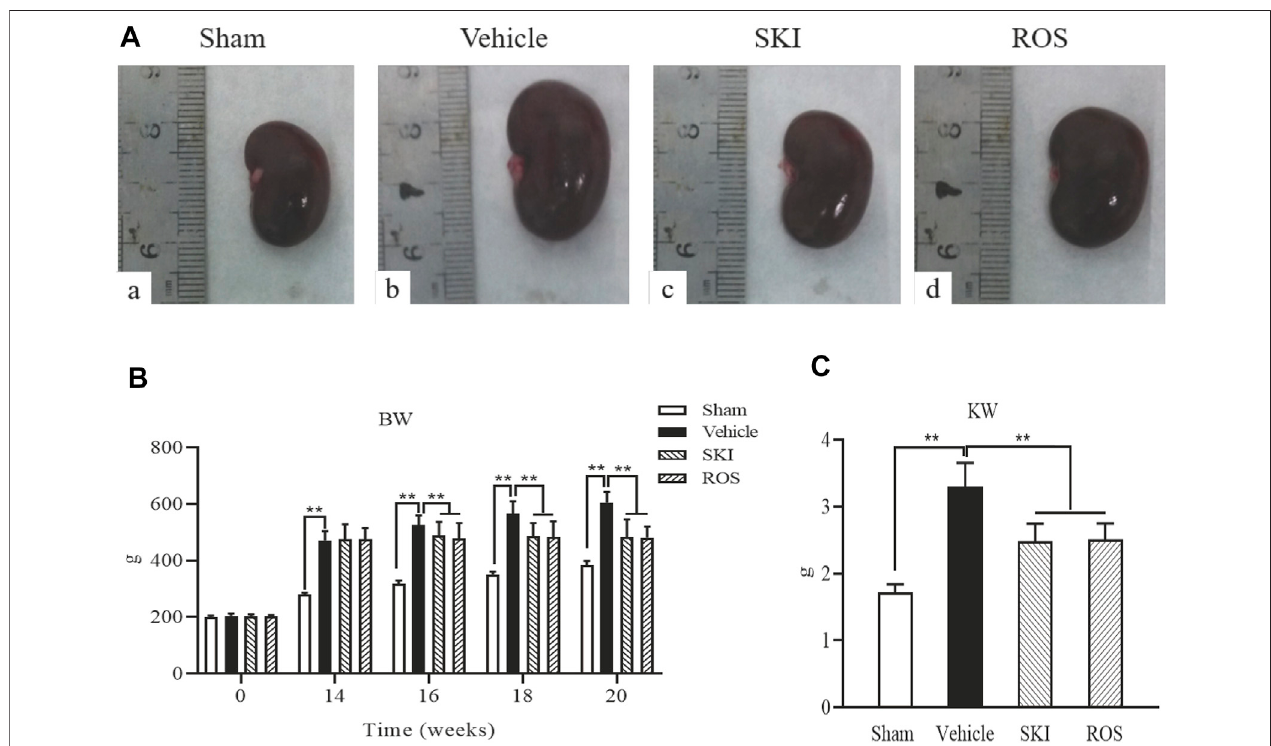
FIGURE 1 | The effects of SKI and ROS on renal morphological appearance (A) , BW (B) , and KW (C) in vivo . Data are expressed as mean ± S.E. * p < 0.05, ** p < 0.01. Abbreviations: BW, body weight; KW, kidney weight; ROS, rosiglitazone; SKI, Shenkang injection.